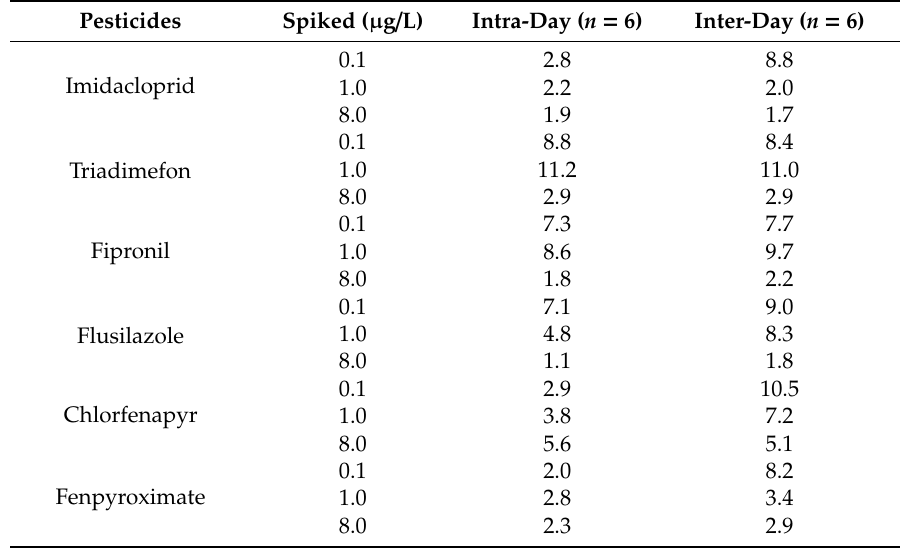
Table 2. Intra-day and inter-day precisions (RSD, %) for MSPE-HPLC determination of the six heterocyclic